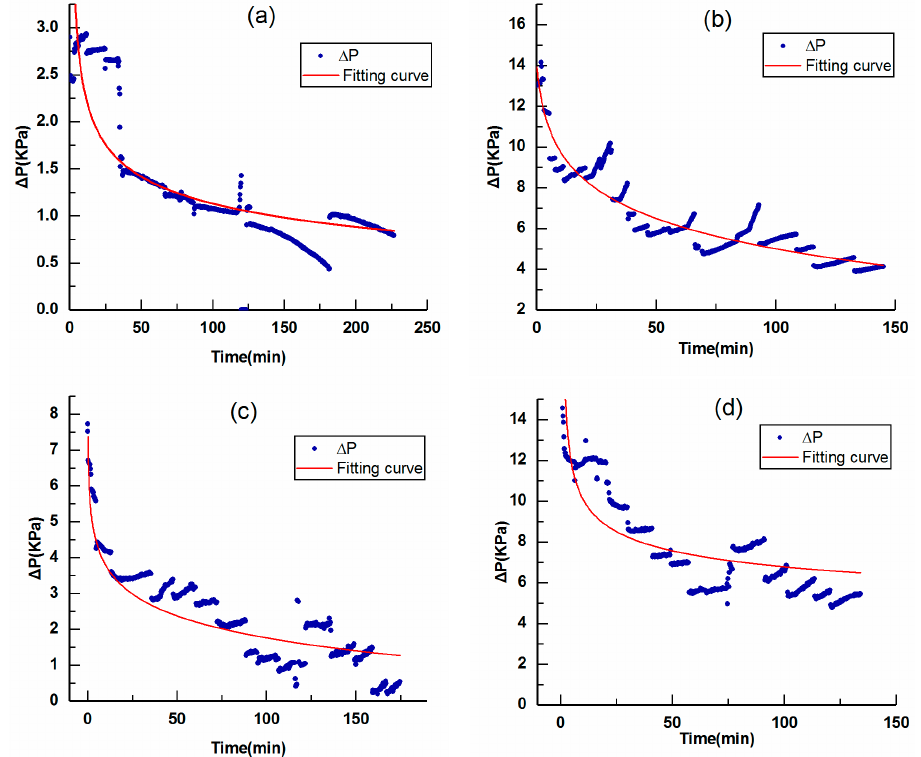
Figure 5. Pressure difference between two ends of the freezing model during natural cold gas injection (( a ) Experiment 1, ( b ) Experiment 2, ( c ) Experiment 3, and ( d ) Experiment 4).